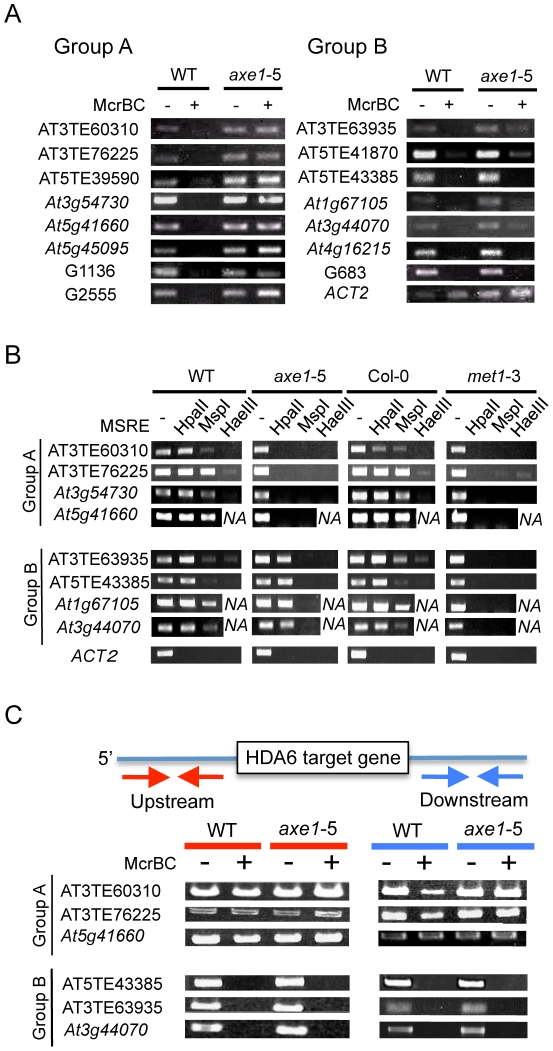
Differential impacts of the hda6 mutation on DNA
methylation at HDA6 target loci.The effect of the hda6 mutation on cytosine methylation
at HDA6 direct targets was determined by; (A) McrBC assays and, (B)
Chop-PCR assays. (A) McrBC-digested genomic DNA was amplified by PCR.
(B) Chop-PCR assays were conducted using the methylation sensitive
restriction enzymes HpaII (which reports CG
methylation), MspI (which reports CHG methylation), and
HaeIII (which reports CHH methylation). Genomic DNA
digested with each enzyme was amplified by PCR. NA indicates that the
amplified sequences do not include the HaeIII
recognition sequence GGCC. In each assay, undigested genomic DNA was
used as a PCR control. ACT2 served as a control for
enzymatic digestion. (C) The DNA methylation status for flanking regions
of HDA6 target loci was determined using McrBC assays. The regions from
around 2 kb to 0.5 kb (i.e. 1.5 kb) of upstream (left panel, red
arrows), and downstream (right panel, blue arrows), of HDA6 target loci
were assessed. Absence of flanking methylated regions around the HDA6
target loci correlated with the loss of CG methylation in
axe1-5. Primers are listed in Table
S8.